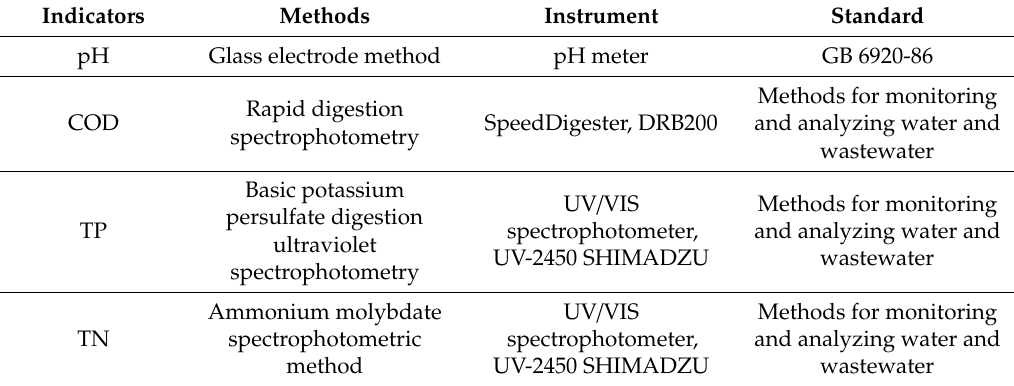
Table 1. Test method of each